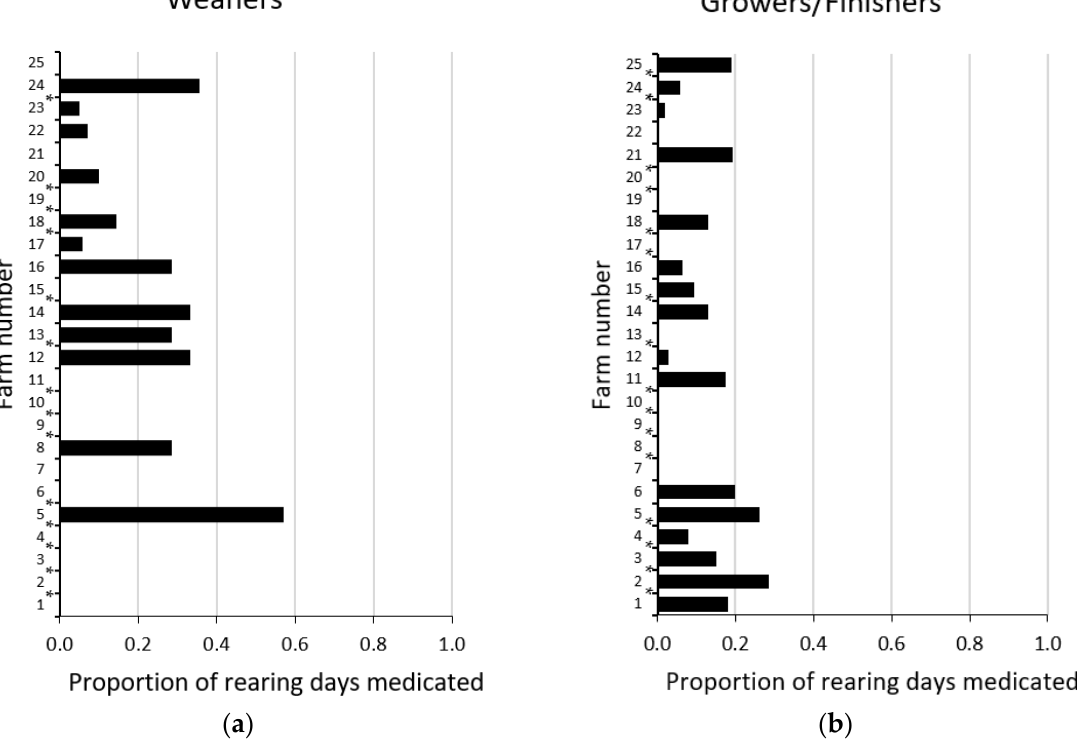
Figure 3. ( a ) Proportion of total rearing days on which one or more antibiotics were administered in-water to weaner pigs for metaphylaxis. ( b ) Proportion of total rearing days on which one or more antibiotics were administered in-water to grower/finisher pigs for metaphylaxis. (25 single-site and multi-site pig farming enterprises, 459,167 growing pigs). Descriptive statistics for weaners: median, 0.00; range, 0.00–0.57; Quartile (Q) 1, 0.00; Q3, 0.29; interquartile range (IQR), 0.29. Descriptive statistics for grower/finishers: median, 0.06; range, 0.00–0.29; Q1, 0.00; Q3, 0.18; IQR: 0.18. Note: * symbol indicates that one or more antibiotics were also administered in-feed to pigs on any rearing days.